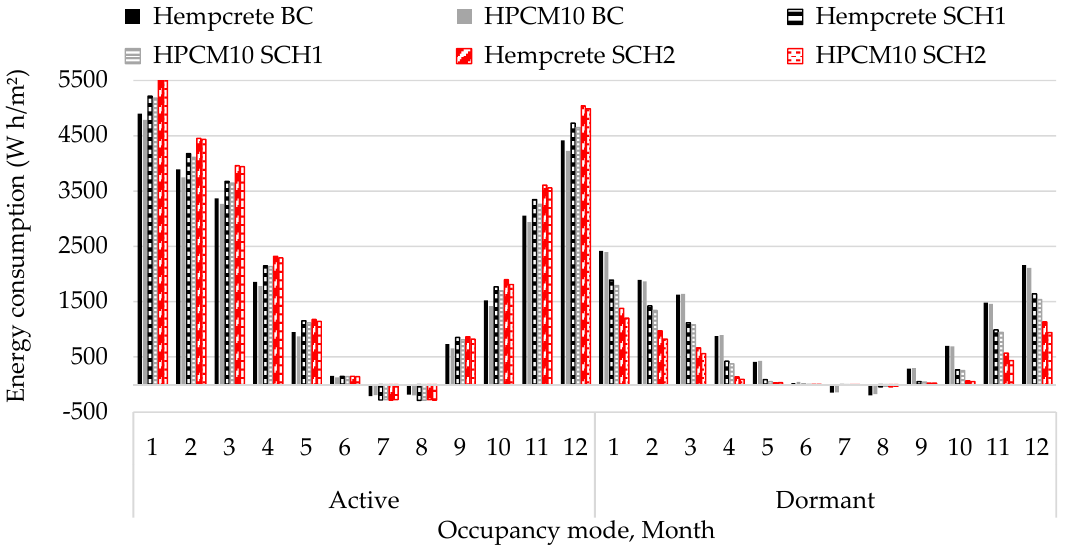
Figure 8. Average monthly heating and cooling energy consumption under BC, SCH1, and SCH2.